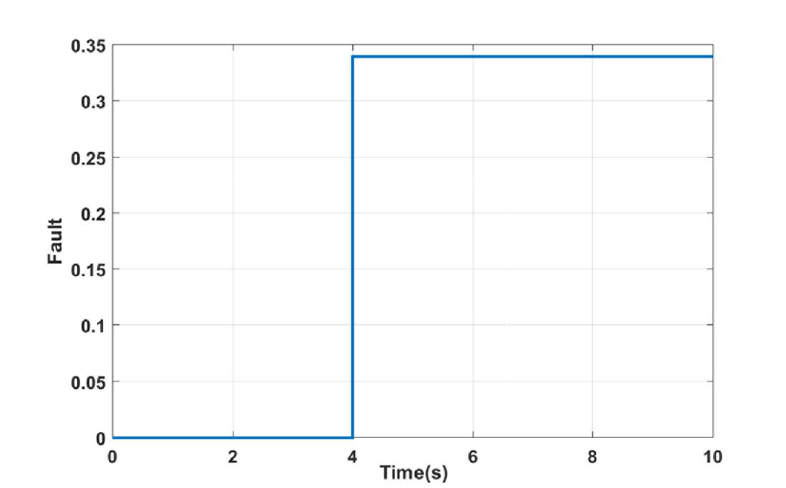
Figure 6. Vehicle front steering angle.